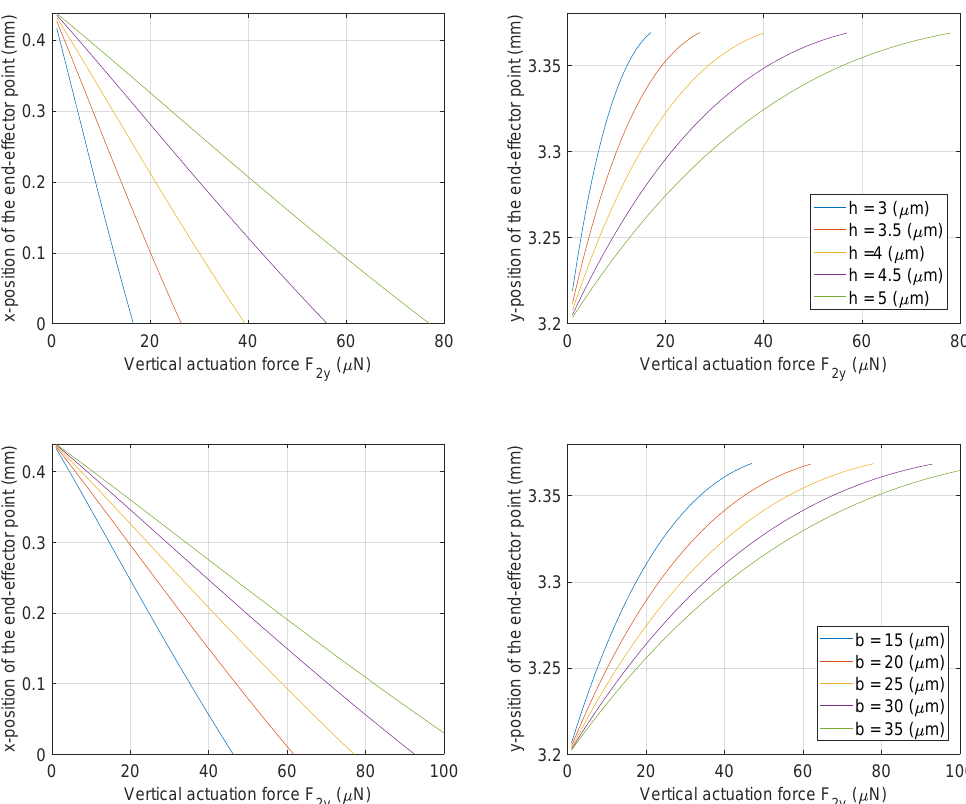
Figure 10. Cross-section optimization of the flexures.